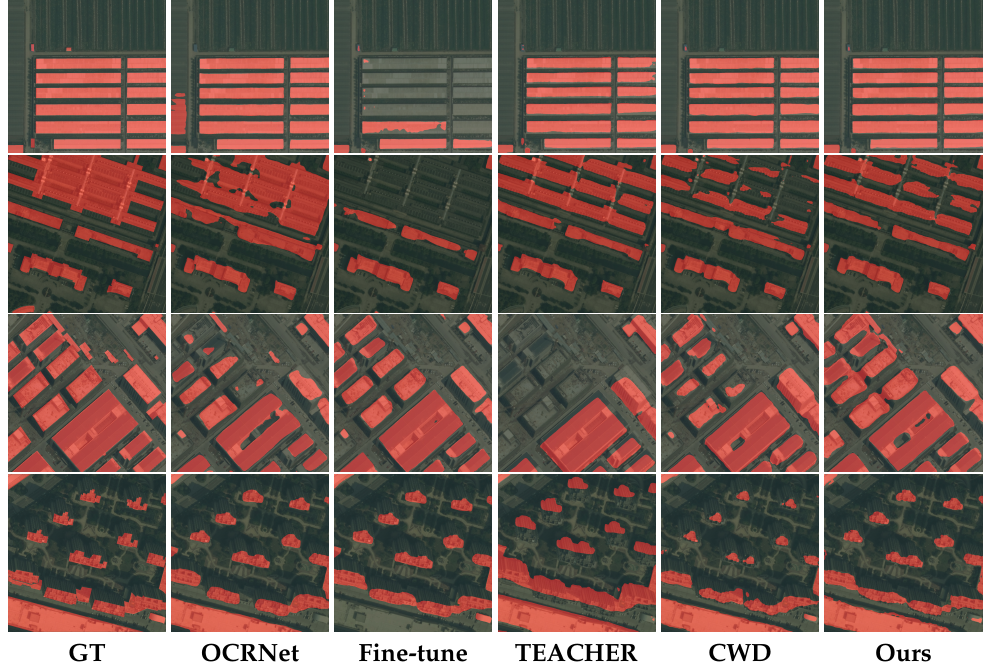
Figure 10. Visualization of the superimposed images of the results of the different building segmen- tation methods. One column represents a method, and the first column represents ground truth. Buildings are shown in